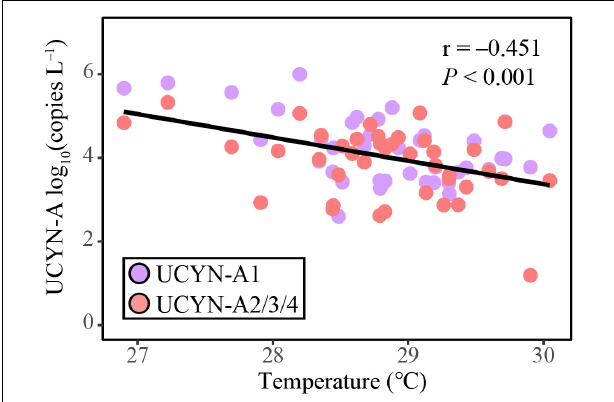
FIGURE 7 | The correlation between UCYN-A abundance and sea surface temperature, estimated by linear least-squares regression.